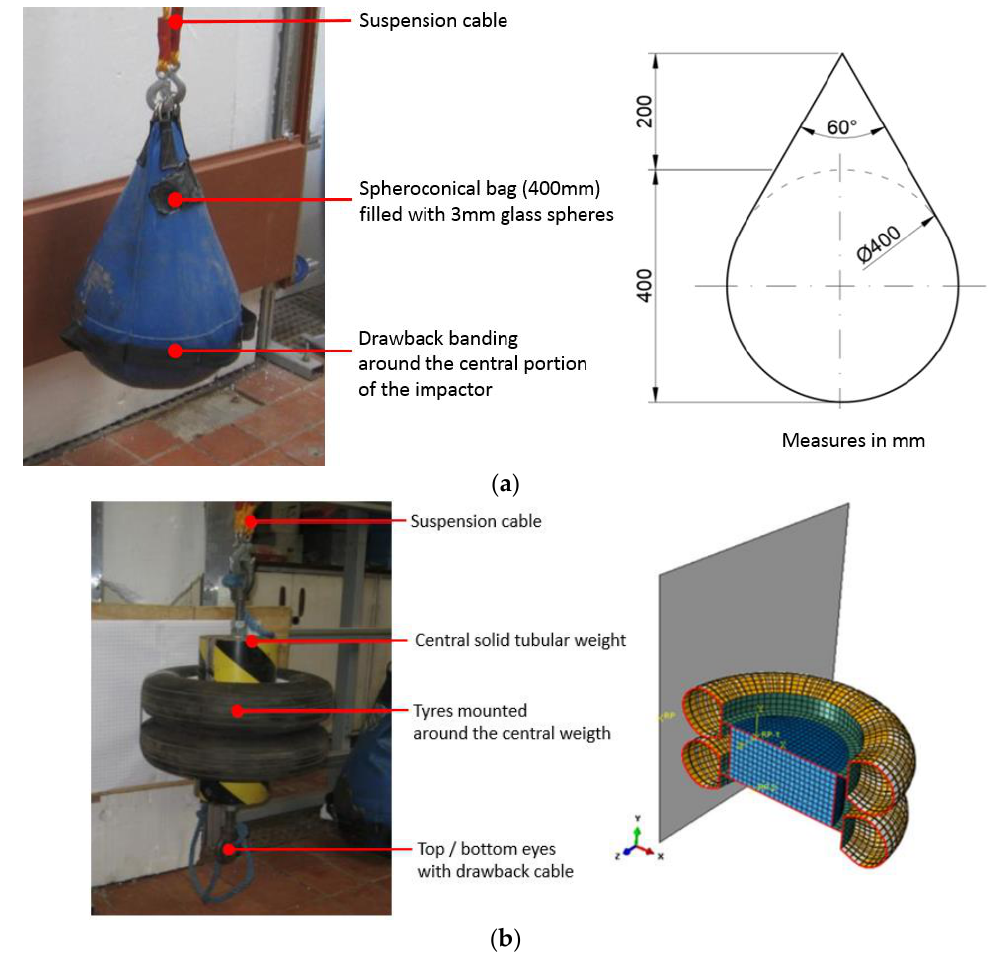
Figure 2. Standardized impactors for glass curtain walls: ( a ) spheroconical bag (SB, with nominal dimensions in mm) or ( b ) twin-tire (TT) impactor (with FE model detail).